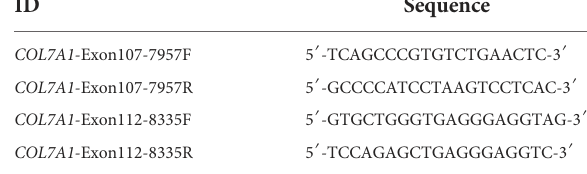
TABLE 1 Primers of COL7A1 used in this